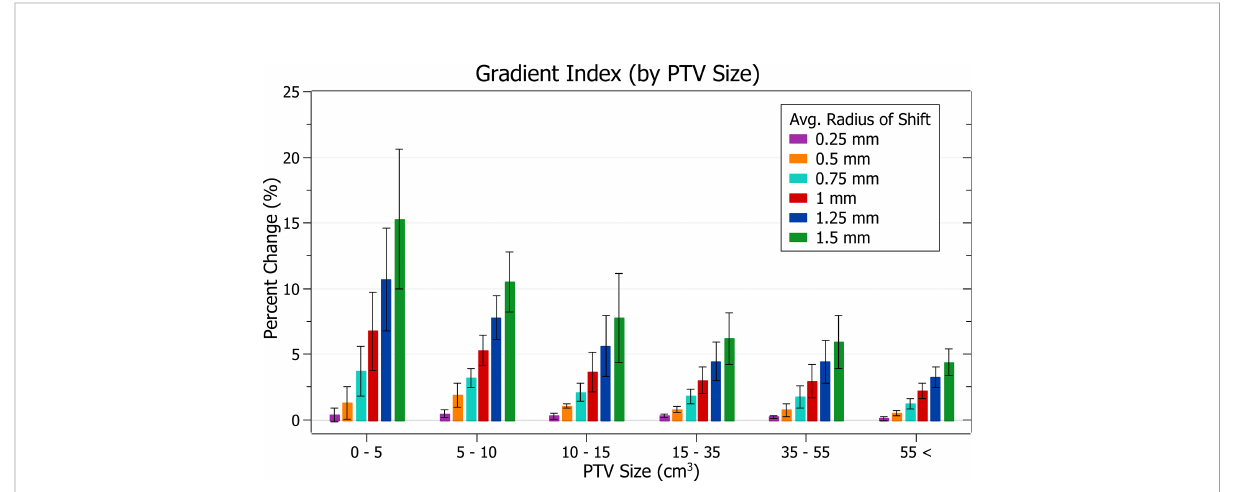
FIGURE 11 Average percentage change of gradient index for different radii of isocentre shift, categorised by PTV